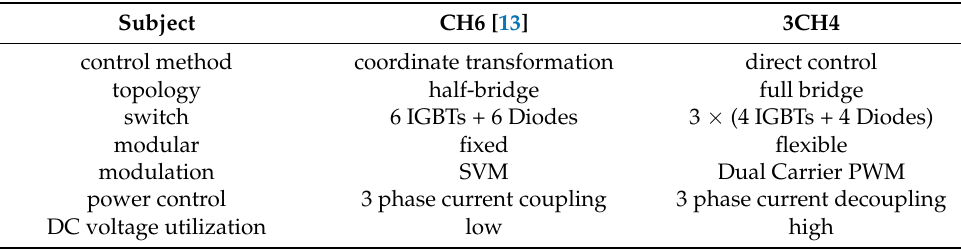
Table 2. 3CH4 vs. Table 2. 3CH4 vs. CH6.